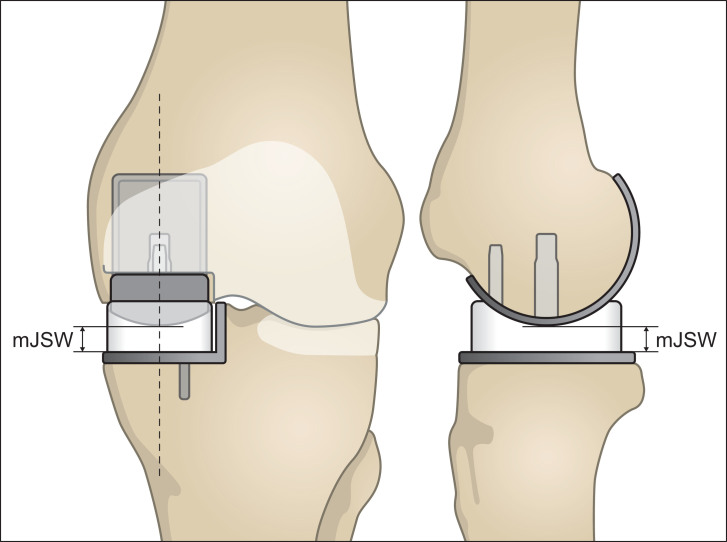
The frontal view to the left outlines the measurement of the minimal joint space width (mJSW). The dotted line represents the sagittal cross-sectional view presented to the right. The mJSW reflects the bearing thickness and the projected dotted line on the tibial component represents the femorotibial contact point. This allows the estimation of PE wear and the position of the bearing. Overhang is seen when the bearing exceeds the outline of the tibial plateau. Impingement can be identified if the bearing slides against the vertical wall (see frontal view).